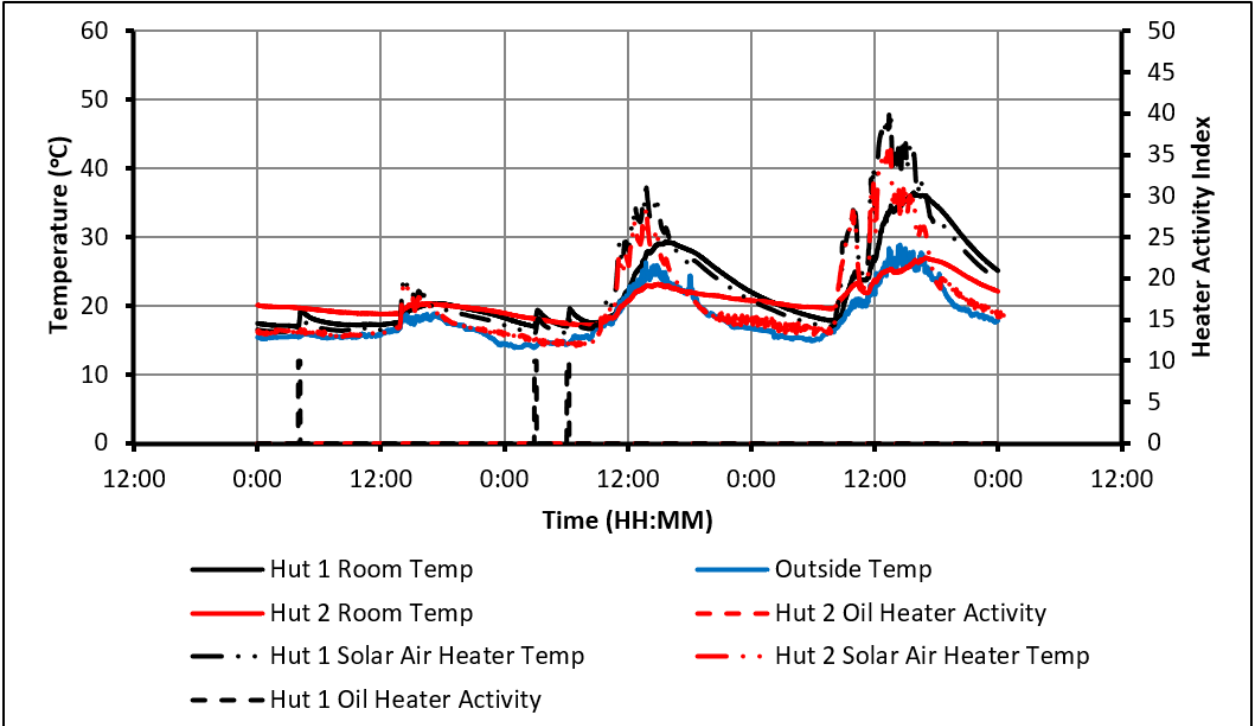
Figure 12. Temperature profiles and heater activity (17 – 19 °C temp. constraints, days 12 – 14)